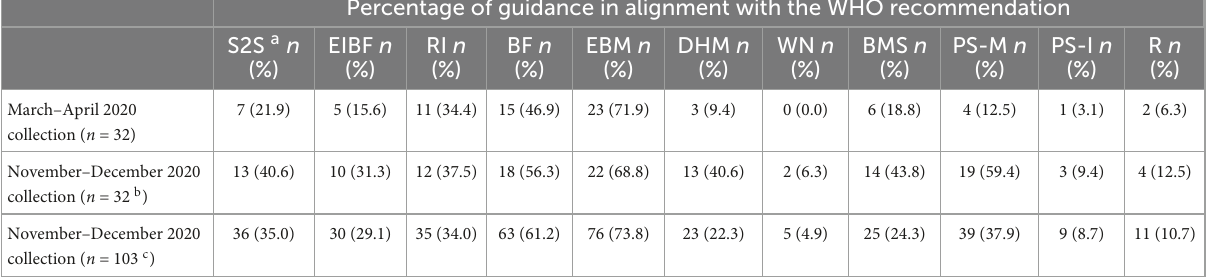
TABLE 3 Frequency of country and regional guidance in alignment with each of the eleven World Health Organization (WHO) COVID-19 recommendations for maternal and newborn care in guidance collected March-April 2020 and November-December 2020. Percentage of guidance in alignment with the WHO